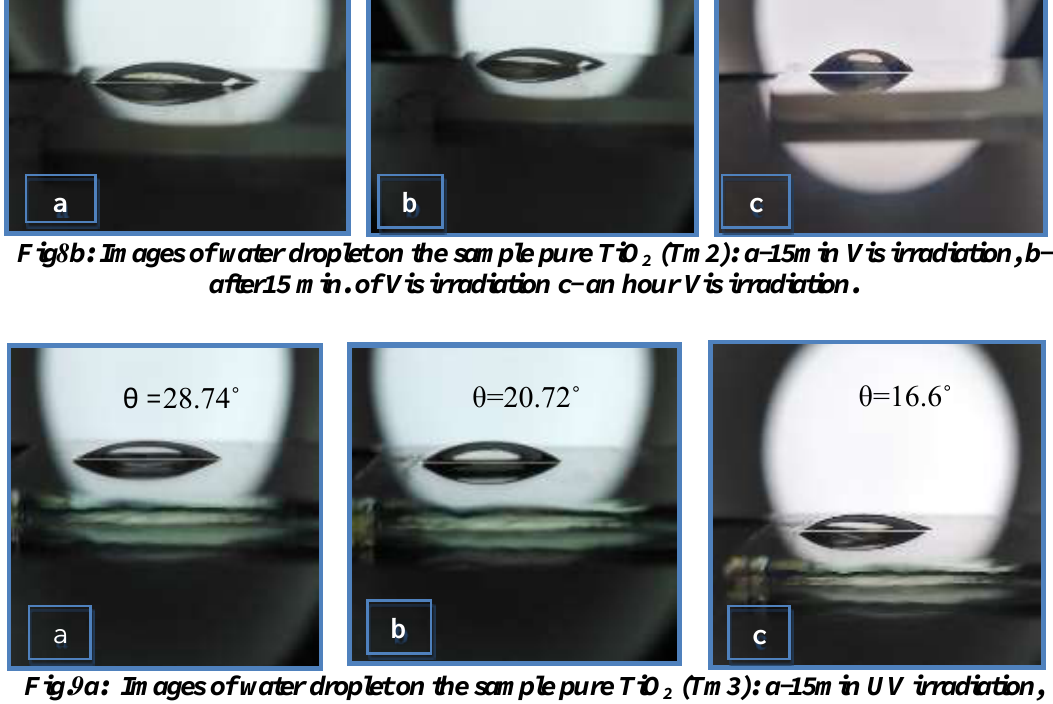
Fig.9a: Images of water droplet on the sample pure TiO b- after15 min. of UV irradiation c- an hour UV irradiation.